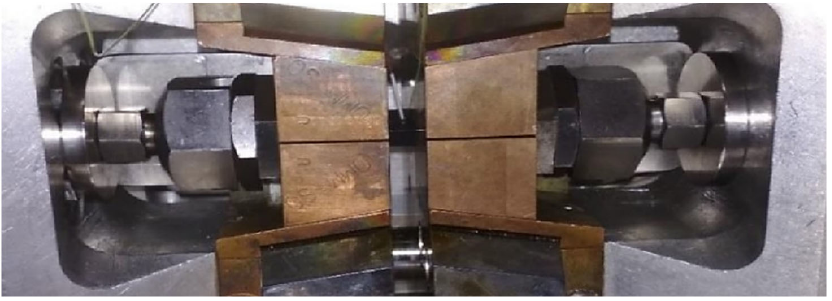
Figure 7. Sample in the device Gleeble 3500.